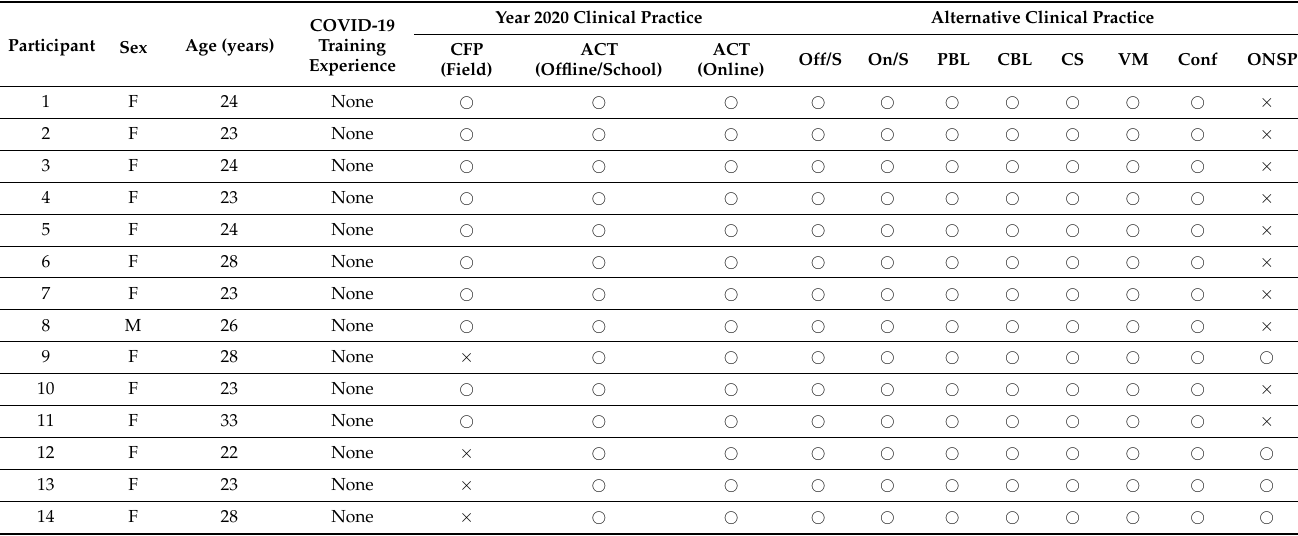
Table 3. General characteristics of the